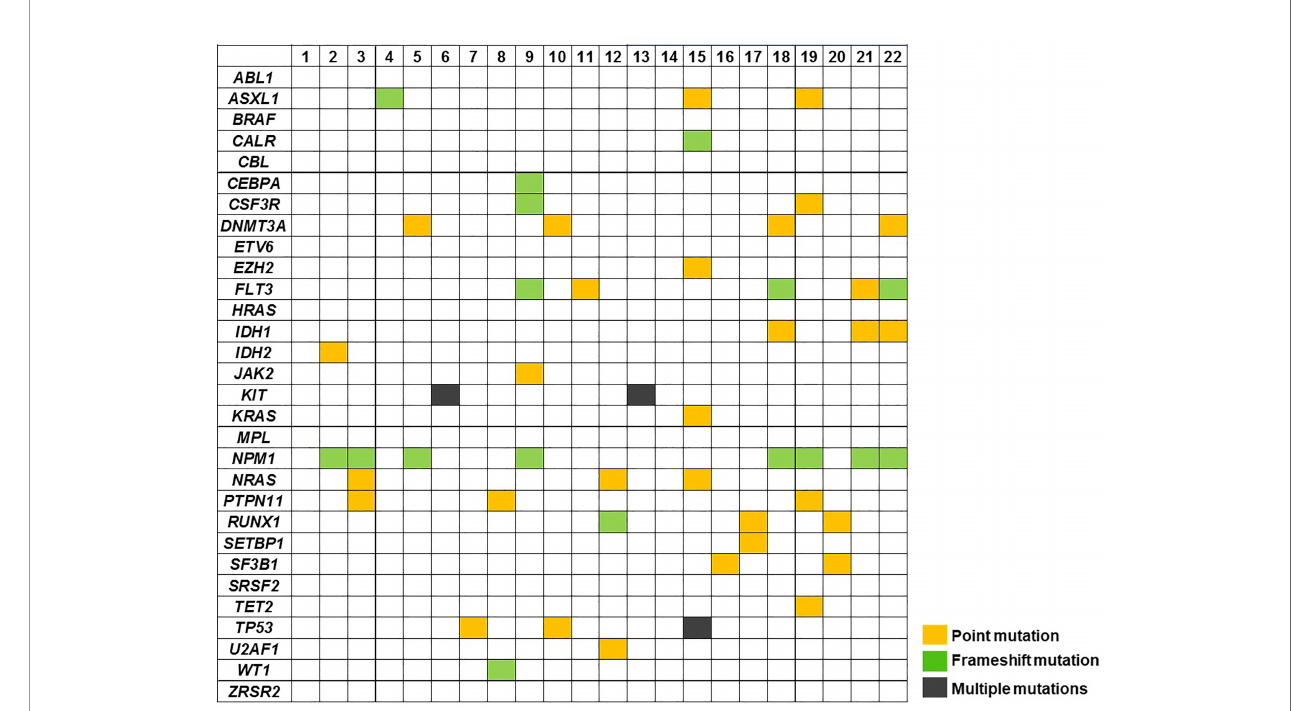
FIGURE 3 | Mutation pro fi le of AML cases at diagnosis (n=22) using targeted NGS. Patient samples are displayed as